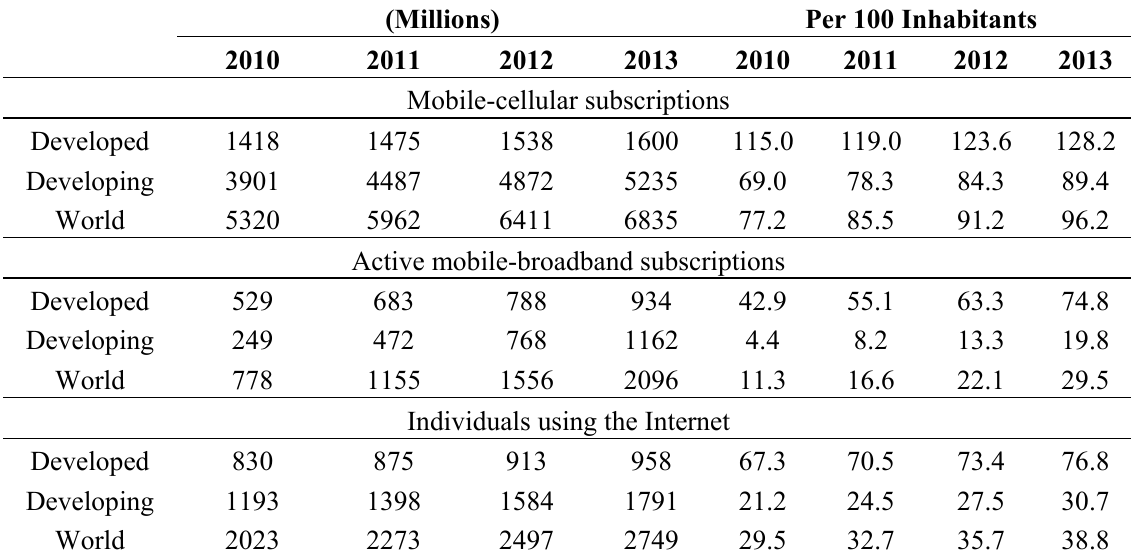
Table 1. Key ICT indicators for developed and developing countries and the world (totals and penetration rates) (ITU